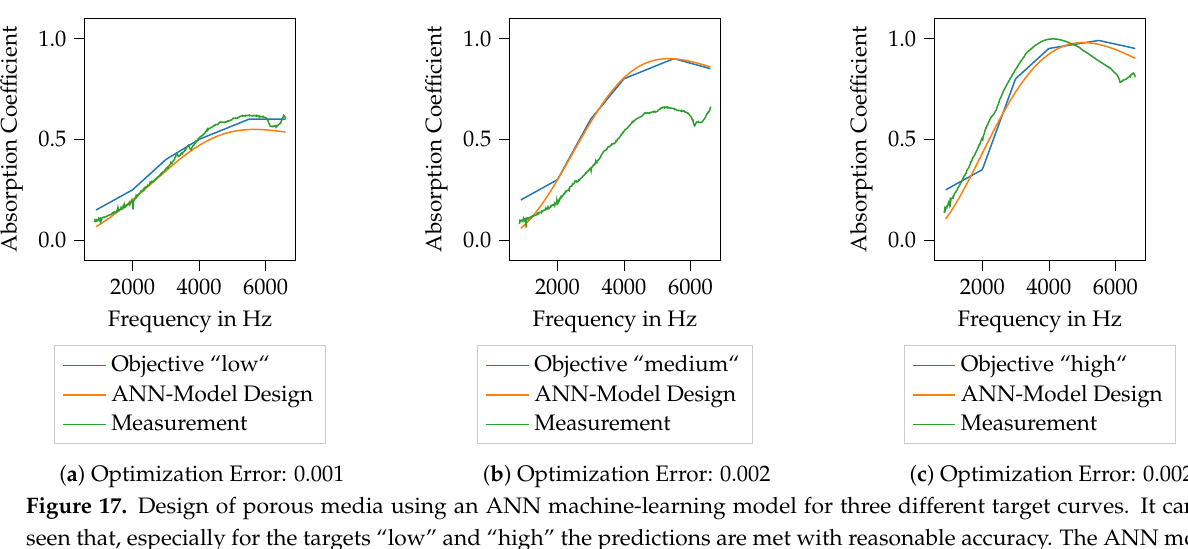
Figure 17. Design of porous media using an ANN machine-learning model for three different target curves. It can be seen that, especially for the targets “low” and “high” the predictions are met with reasonable accuracy. The ANN model is able to extrapolate from the know data range, as the prediction follows the target curves for “medium” and “high” above approx. 5000 Hz. The large deviations of the measurement for the target “medium” are expected to result from manufacturing